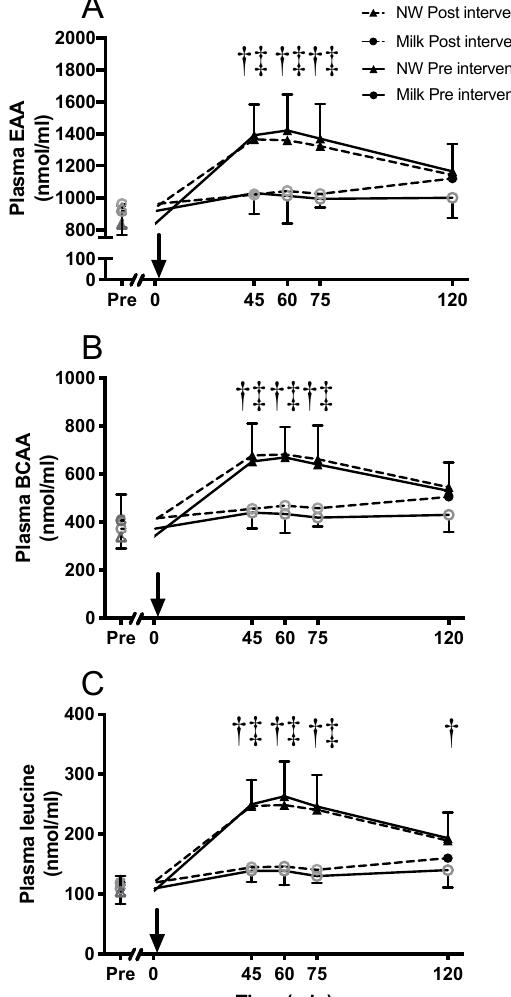
Figure 5. Blood concentrations of total amino acids ( A ), essential amino acids ( B ), and leucine ( C ) following intake of milk or native whey immediately after a bout of resistance exercise in the elderly. Arrow indicates time point of protein supplement ingestion. Values are mean ± SD (only shown for the highest and lowest values). n = 9 and 11 in the milk group and native whey group, respectively. Data were analyzed with a two-way repeated measures ANOVA (time × supplement). Multiple comparisons tests were used as post-hoc tests to specify the significant di ff erences between groups (Tukey) and time points (Dunnet). Black data points indicate a di ff erence form resting values; gray data points indicate no significant di ff erence from resting levels. † milk and native whey di ff erent at pre, ‡ milk and native whey di ff erent at post p < 0.05.